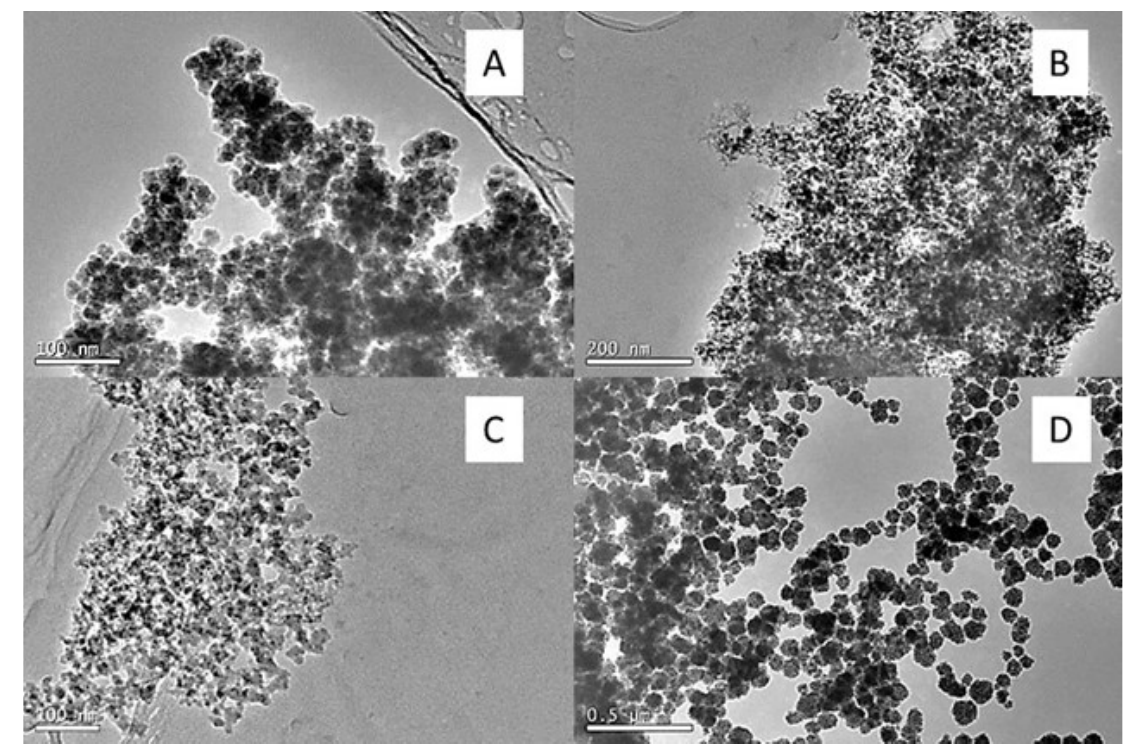
Figure 5. Transmission micrographs of Fe 3 O 4 @SiO 2 ; ( A ) and ( B ) method D, E; ( C ) method G; ( D ) method H.